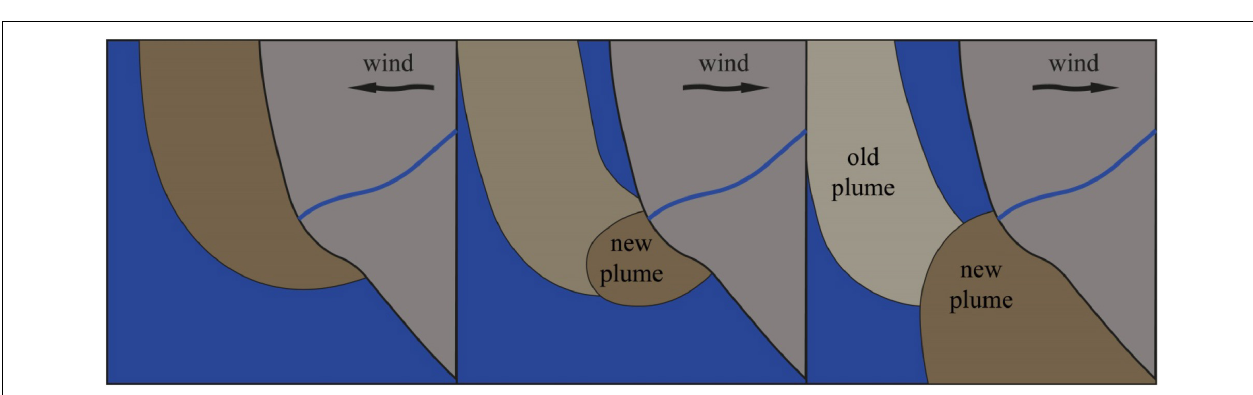
Frontiers in Marine Science |